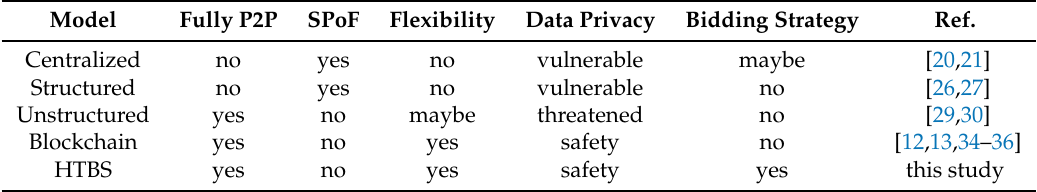
Table 1. Review on Transaction Model between Microgrids.